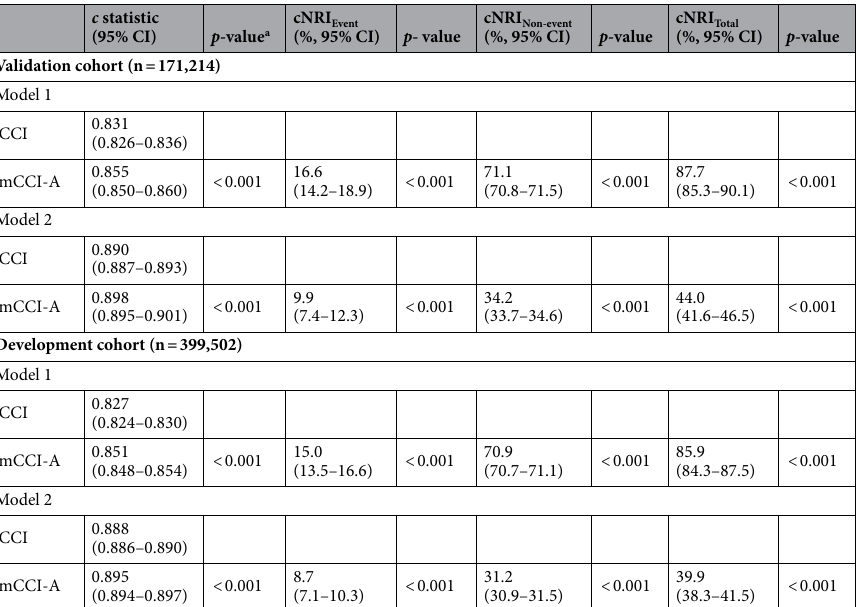
Table 4. Model performance of the mCCI-A in the validation and development cohorts. cNRI, continuous net reclassification improvement; CCI, Charlson Comorbidity Index; mCCI-A, modified version of the Charlson Comorbidity Index for Asian populations; cNRI Total = cNRI Event + cNRI Non-event . Model 1; univariate. Model 2; adjusted for age (quartile), sex, region and family income ratio (11 groups). a p -value for the c statistic was taken and computed for a contrast test.